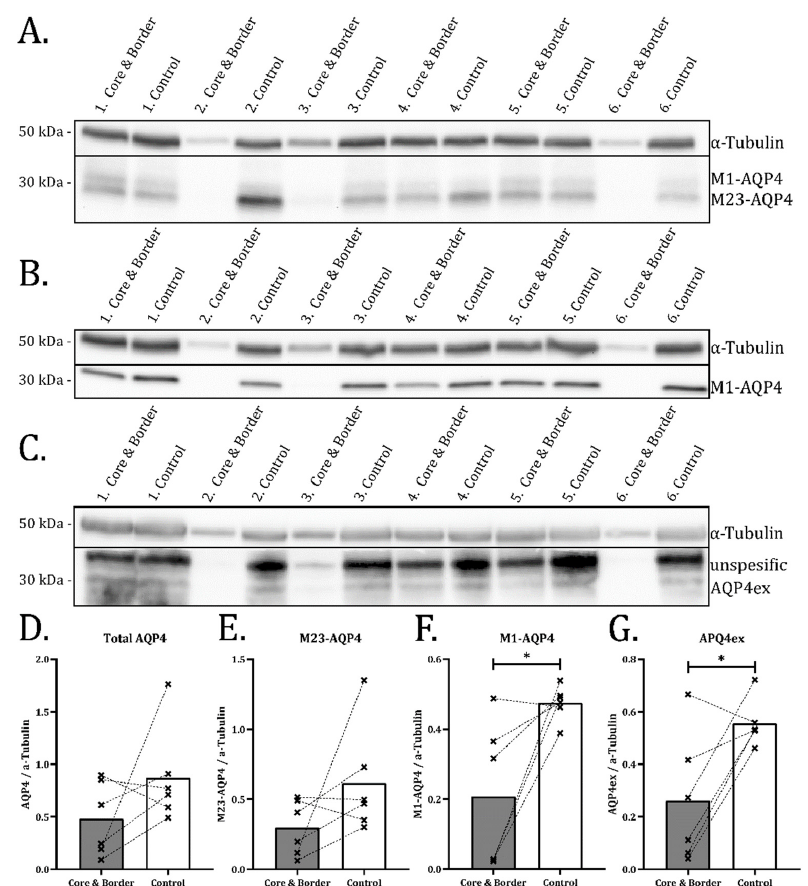
Figure 5. M1-AQP4 and AQP4ex is reduced in infarct samples seen with SDS-PAGE. SDS-PAGE of infarct samples (including core and border zone) and contralateral control. Western blots stained with anti-AQP4 ( A ), anti-M1-AQP4 ( B ) and anti-AQP4ex ( C ). α -Tubulin was used as loading control for all membranes ( A – C ) and for normalization in the semiquantitative analysis ( D – G ). Normalized densitometric values from ( A ) shown in ( D , E ). Values from ( B ) shown in ( F ), and ( C ) in ( G ). ( D – G ) dotted lines connect values form the same animal. Paired Student’s t -test ( n = 6) was used for statistical analysis. ( F , G ) show significant reductions in M1-AQP4 ( p = 0.027) and AQP4ex ( p = 0.028) in infarct tissue (core and border) compared to contralateral control. No statistically significant differences were found for total AQP4 or M23-AQP4 in infarct samples compared to control. Uncut membranes provided in Figure S3. Asterisk indicates significant difference.